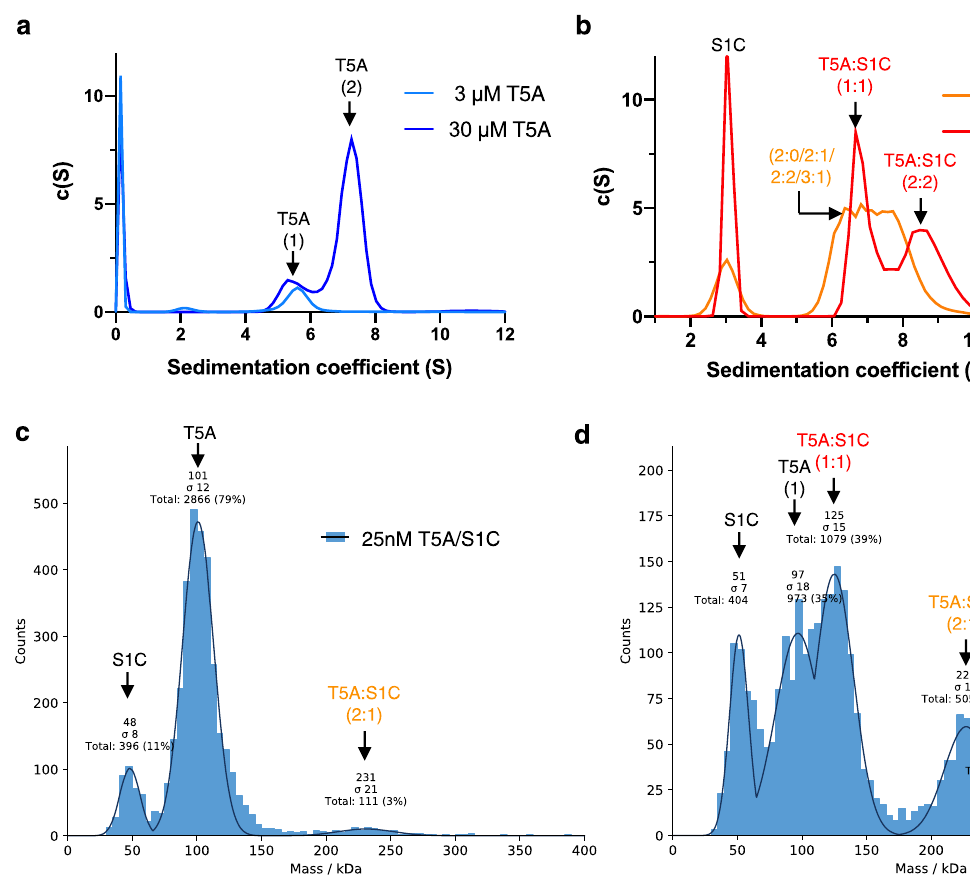
Fig. 4 | Slow exchanges in receptor-receptor interactions in the absence of ligand contrast with fast dynamics in the presence of ligand. AUC sedimenta- tion velocity pro fi les and the shifts in sedimentation coef fi cients are indicative of dynamical behaviour or the receptor in the presence and the absence of its ligand